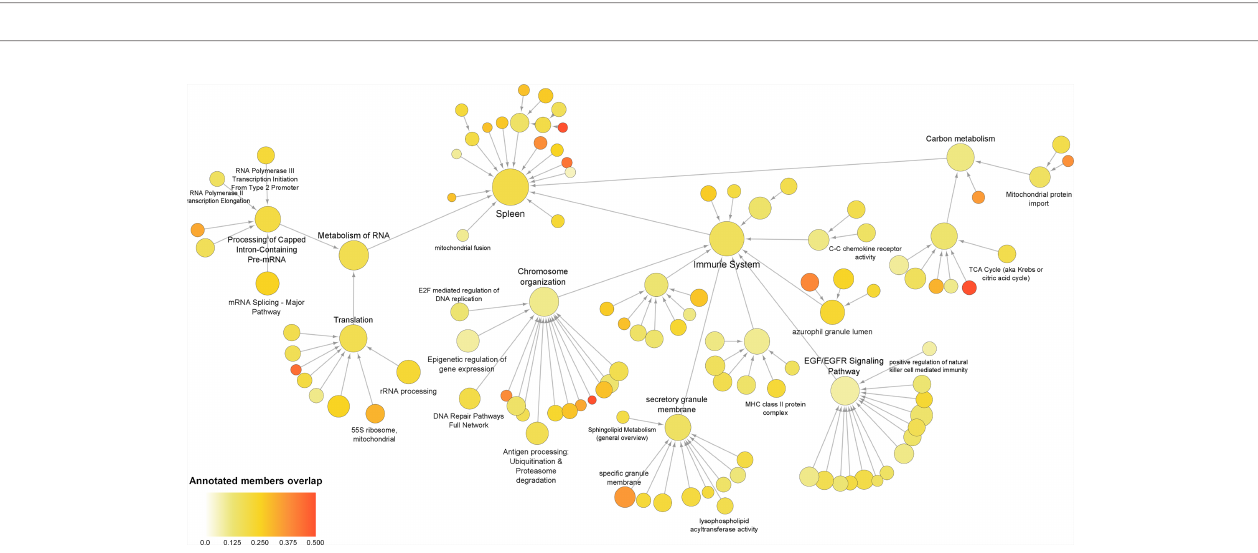
FIGURE 4 | Multiscale community of the global sepsis PPIN. Node size represents the number of genes/proteins annotated in the process. Color scale represents the ratio of overlapping genes in each annotation. Information on these identi fi ed communities and annotated members is presented in Supplemental Material 5